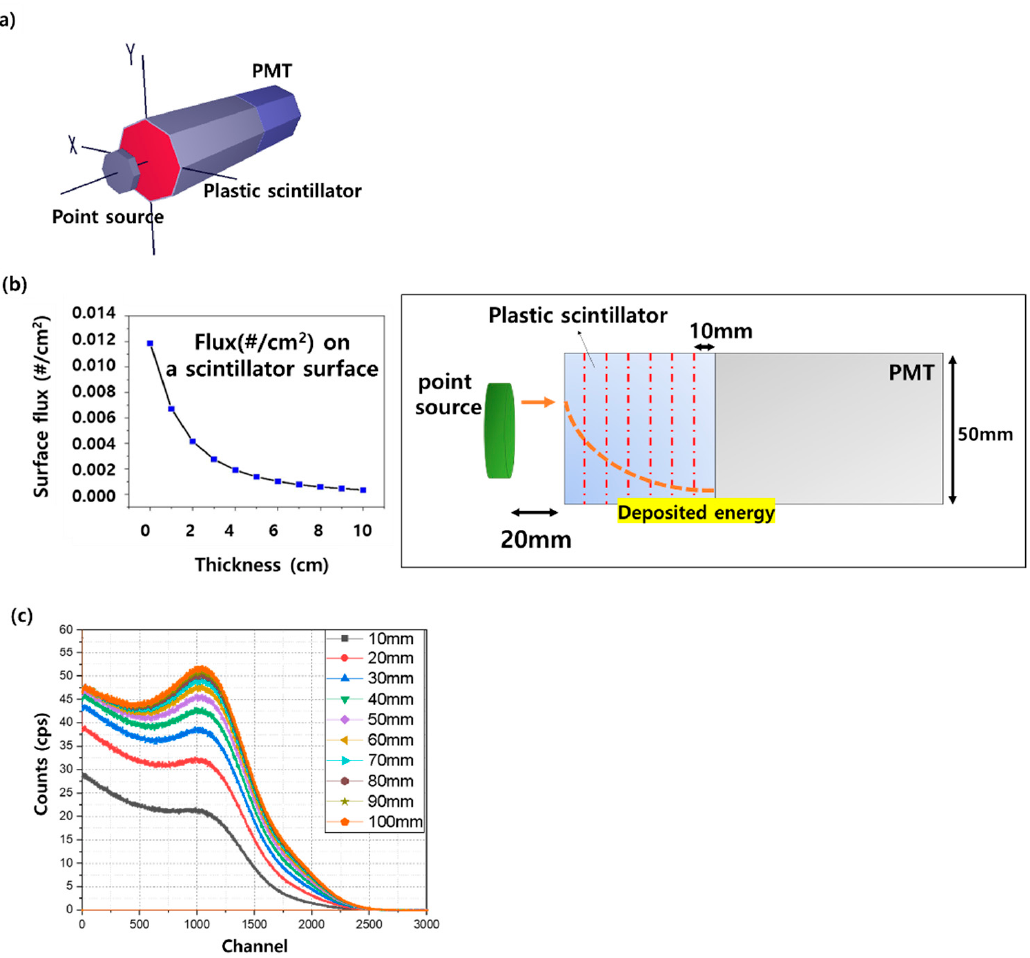
Figure 3. The geometry used in the MCNP computational simulation for the selection of plastic thickness ( a ), flux by thickness ( left ), configuration of geometry ( right ) ( b ), energy spectrum by thickness ( c